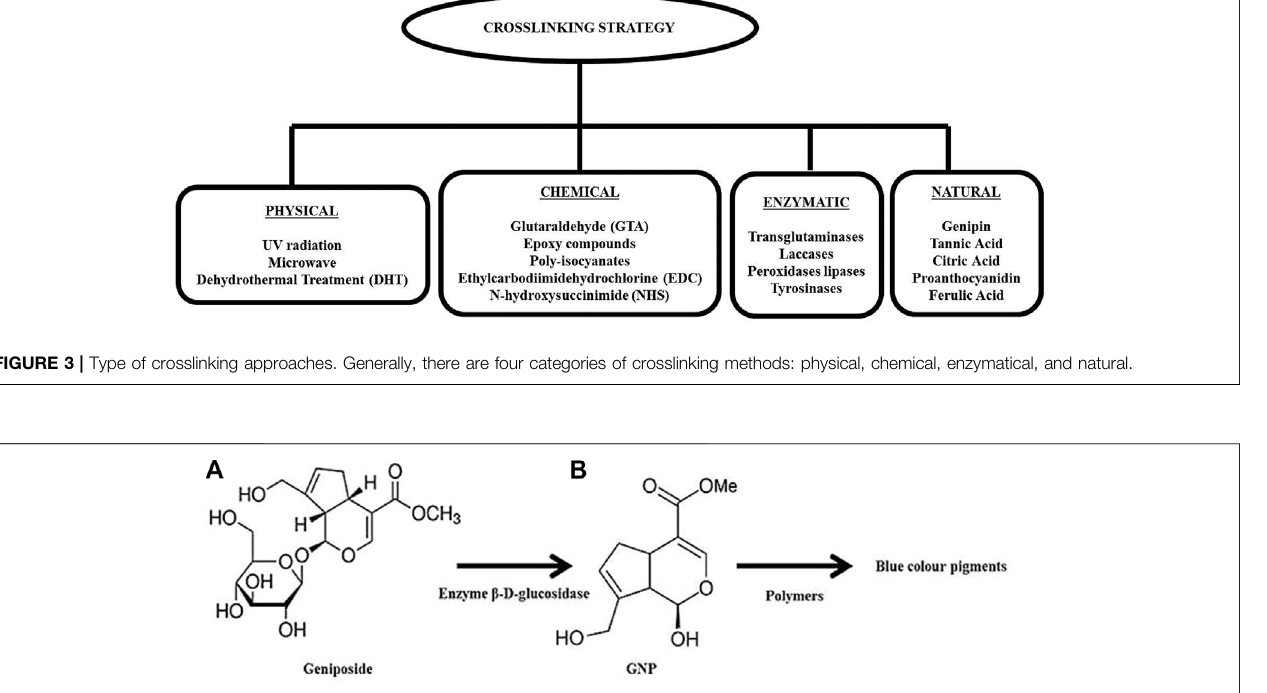
FIGURE 4 | GNP production through geniposide hydrolysis. Crosslinking reaction between GNP and polymers leads to the formation of dark blue